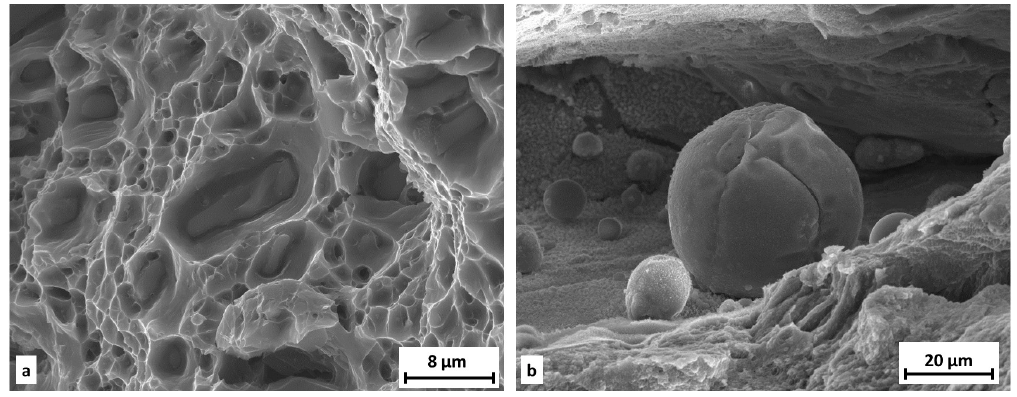
Figure 19. Fraction area of tensile testing samples; ( a ) intermediate particles in dimples; ( b ) unmelted powder in pore.